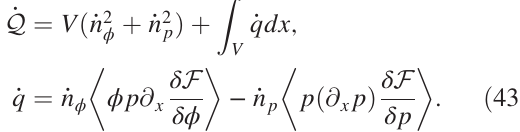
ffiffiffiffiffiffiffiffiffiffiffiffiffiffi p ϕ − ¯ ϕ g . d